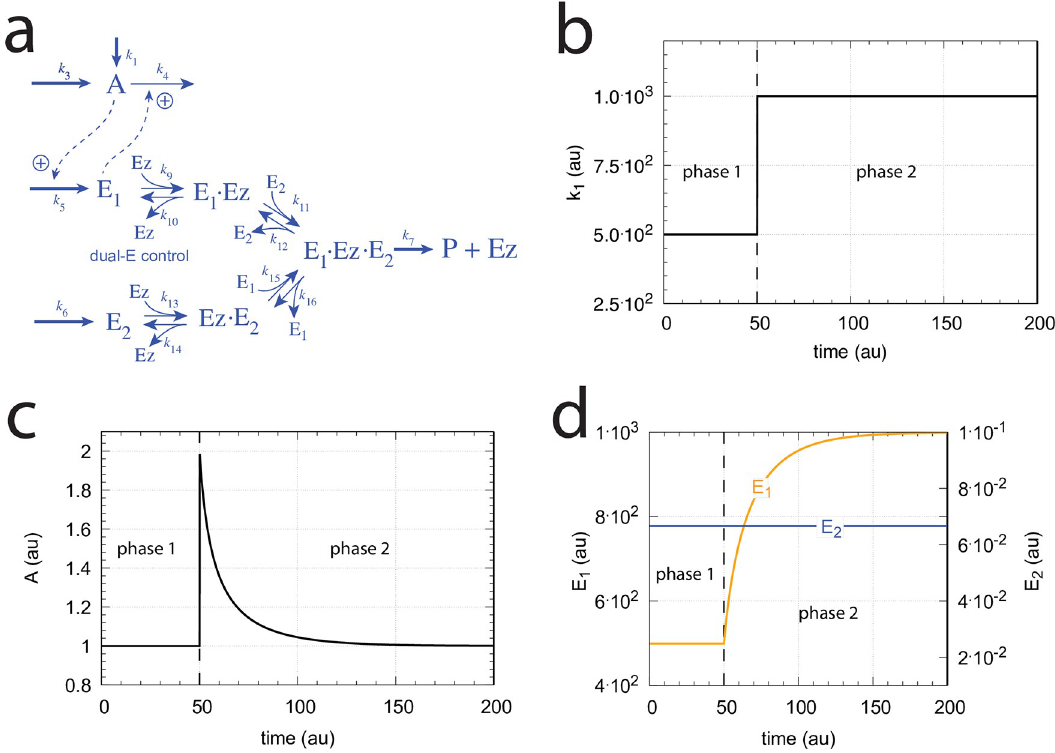
Fig 29. Example of m5 feedback loop where E 1 and E 2 are removed by a random-order ternary-complex mechanism which works under dual-E control. (a) Reaction scheme. (b) Step-wise change of k 1 from 500.0 to 1000.0 at time t = 50. (c) In dual-E mode the set-point is A set = k 6 / k 5 (= 1.0) which is defended. The panel shows the response of A with respect to the step-wise change of k 1 in panel (a). (d) Change of E 1 and E 2 in response to the step-wise change of k 1 in panel (a). Rate constants: k 1 =500.0 (phase 1), k 1 =1000.0 (phase 2), k 2 =1.0, k 3 =0.0, k 4 =1.0, k 5 =40.0, k 6 =40.0 k 7 =1 × 10 8 , k 9 = k 11 = k 13 = k 15 =1 × 10 9 , k 10 = k 12 = k 14 = k 16 =1 × 10 3 . Initial concentrations: